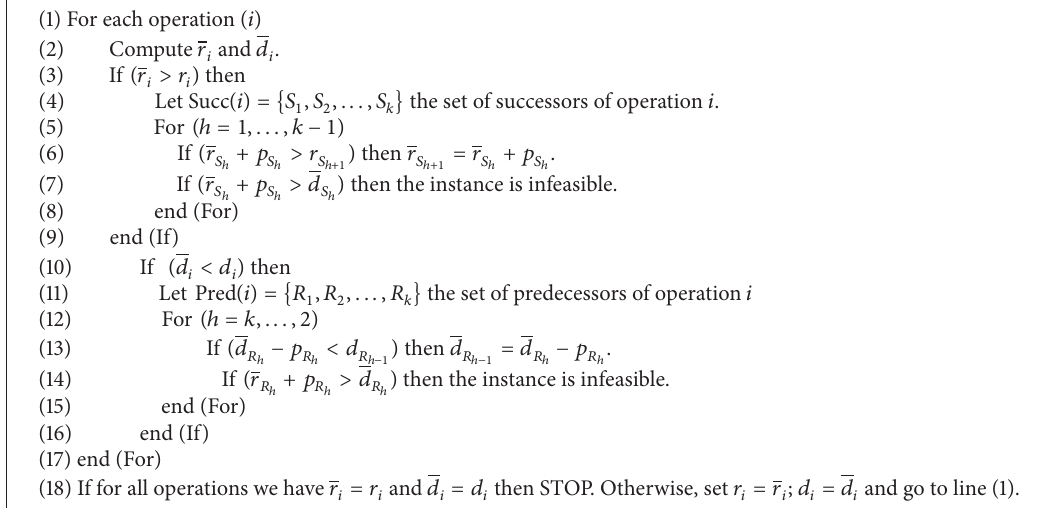
Algorithm 1: Global Adjustment